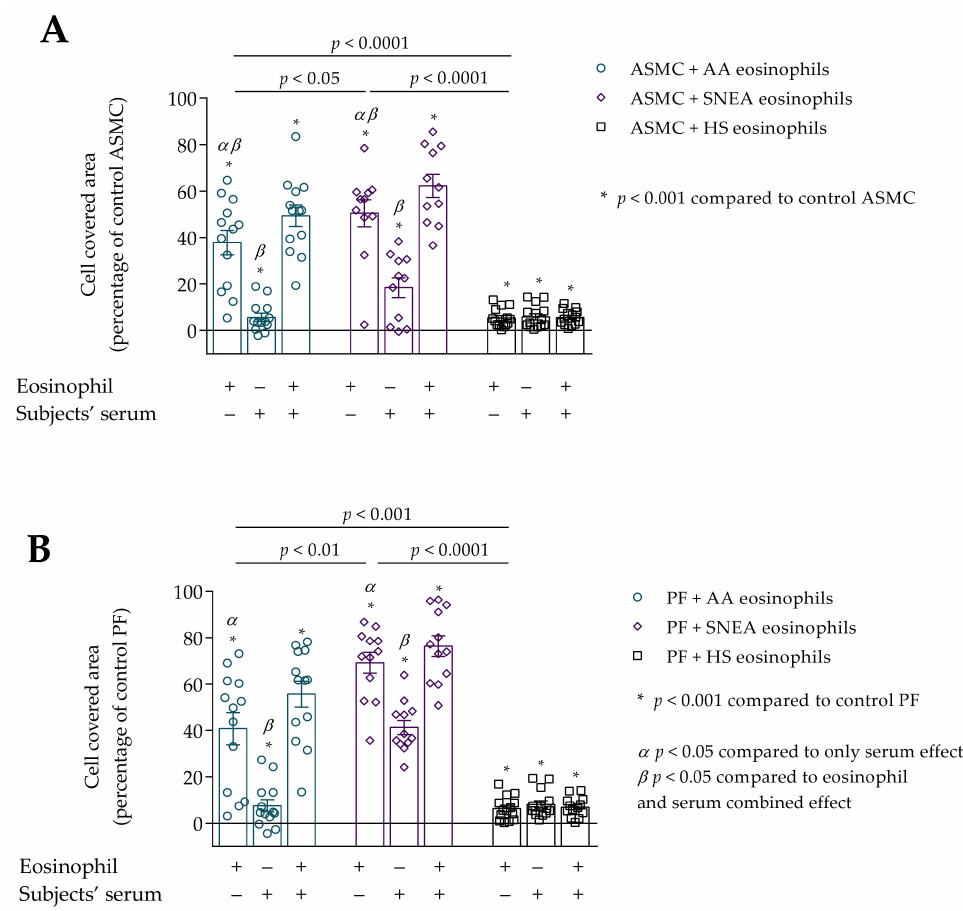
Figure 6. ( A )–Migration of ASMC after incubation with eosinophils and/or subjects’ serum. ( B )–Migration of PF after incubation with eosinophils and/or subjects’ serum. Data presented as cell covered area, as a percentage of control ASMC. Added blood serum of each investigated subject to individual combined cultures: 2% v / v . AA n = 13; SNEA n = 11; HS n = 14. AA—allergic asthma; ASMC—airway smooth muscle cells; HS—healthy subject; PF—pulmonary fibroblast; SNEA—severe non-allergic eosinophilic asthma. α p < 0.05 compared to the only serum effect; β p < 0.05 compared to the eosinophil and serum combined effect; A—* p < 0.001 compared to control ASMC, B—* p < 0.001 compared to control PF. Statistical analysis between investigated groups—Kruskal-Wallis test and post hoc Mann–Whitney two-sided U -test (independent data); within one study group—Friedman test for multiple comparison within the group and the post hoc Wilcoxon matched-pairs signed-rank two-sided test (dependent data). Significant differences were found in the eosinophil effect on ASMC and PF migration between investigated groups by Kruskal-Wallis test, respectively, χ 2 = 22.33, df = 2, p < 0.0001 and χ 2 = 25.93, df = 2, p < 0.0001. Significant differences of ASMC migration were found in AA and SNEA groups by Friedman test, respectively χ 2 = 19.08, df = 2, p < 0.0001; χ 2 = 16.55, df = 2, p < 0.0001. Significant differences of PF migration were found in AA and SNEA groups by Friedman test, respectively, χ 2 = 19.08, df = 2, p < 0.0001; and χ 2 = 14.60, df = 2, p = 0.0007. Lines connect comparison groups with a p -value denoting the significant difference in pair-wise